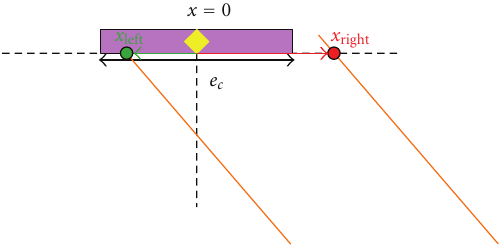
Figure 16: Changes in ratio value. Configuration which may give a very high ratio value.